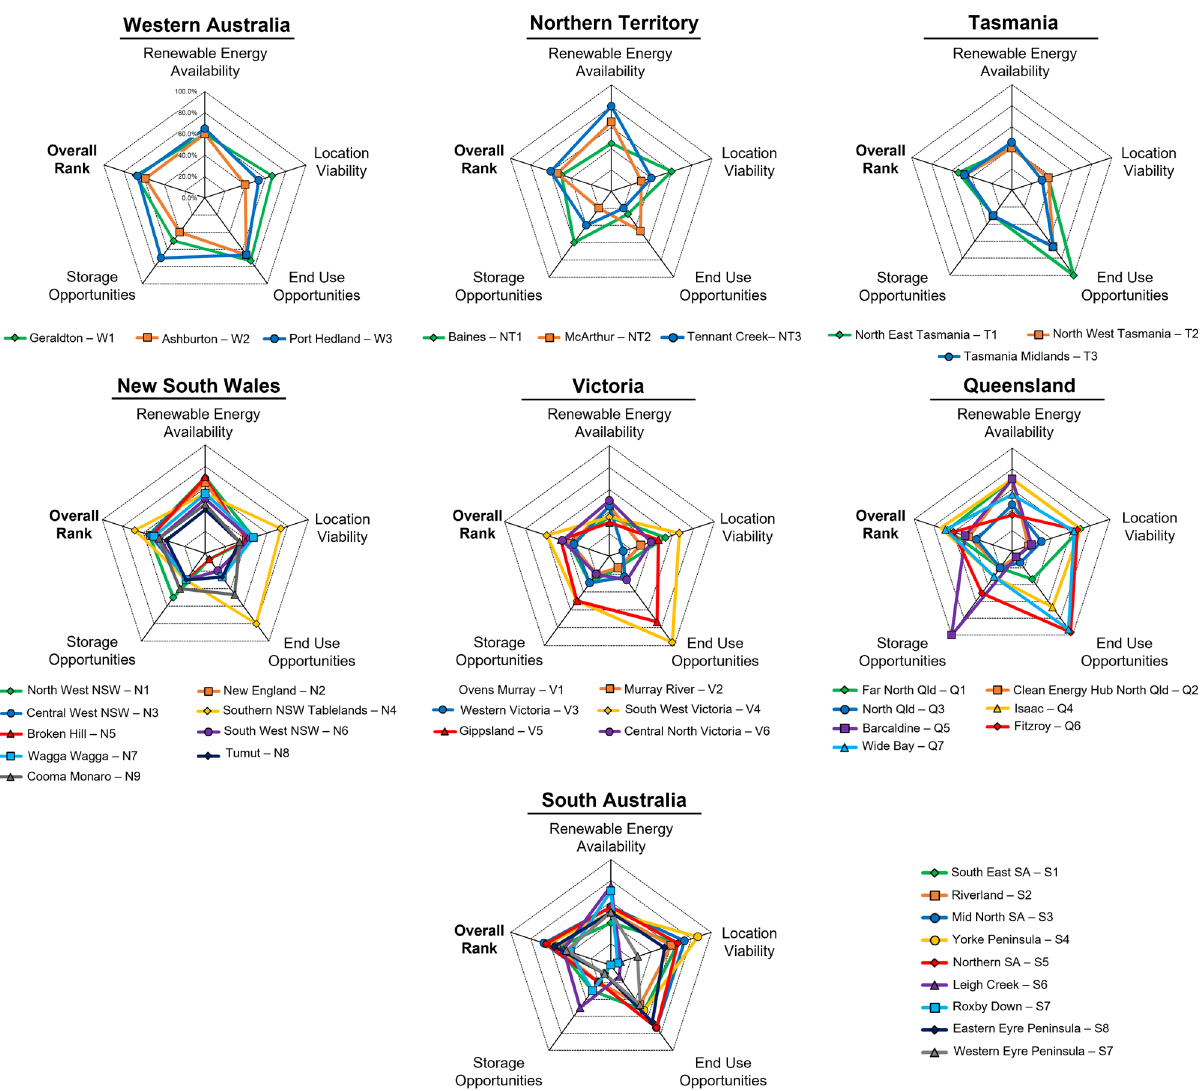
Fig. 3 Results from the MCA Framework. Scores are measured across individual axis of the spider web (solid lines), with each category (overall rank, location viability, etc.) with a score of 0 – 100% (each dotted line represents an interval of 20%). To read the graph, pick a location (represented with different symbols in the keys for each state) and individual category (renewable energy availability, location viability, end use opportunities and storage opportunities), the score for that category is then measurable how far from the centre the symbol is on the axis. E.g., if we chose Geraldton in WA and measure its score for end use opportunity, we see that the symbol lies close to the 4th dotted line from the centre that represents 80%, so for end use opportunities Geraldton scores 80% out of a max score of 100%. Moreover, the wider the distribution (or the more spread out the solid lines — spider web for any given location), the better it ranks in terms of all categories. The score assigned are assigned to each location based on the matrix in Methods section (Table 3), the complete MCA database and ranking for the individual locations is presented in Supplementary Data 2 and the summary of the MCA results for each state is detailed in Supplementary Table tool to determine the LC H2 , by adopting literature-based cost and performance parameters as elaborated in “ Methods ” (refer to Supplementary Tables 6 – 7). Geospatial modelling of solar and wind traces . Of all the con- sidered locational aspects, the renewable energy potential is the most critical factor for green hydrogen generation. Our analysis shows that the highest solar pro fi les are available in Northern Territory (NT), SA, QLD, and WA (and lowest in Victoria — VIC and Tasmania — TAS), with the average solar capacity factors (average of all the considered sites in each state) in order of; (i)